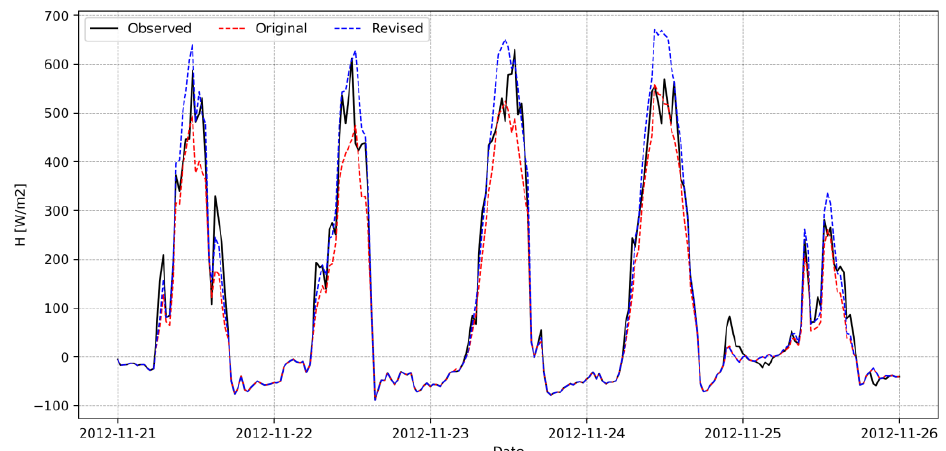
Figure 15. Variations in the observed and simulated sensible heat flux by the original and the revised parameterization at 30 min temporal resolution over five days at the AU-Emr